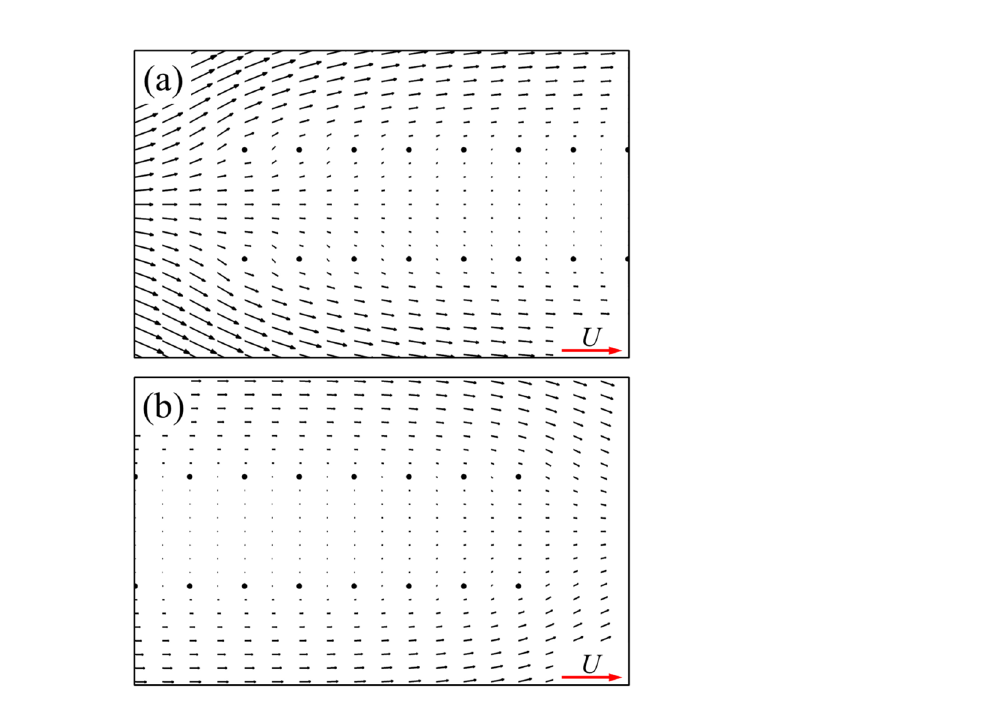
Figure 14. The plot of non-dimensional velocity vector around ( a ) the leading edge and ( b ) the trailing edge of two bristled